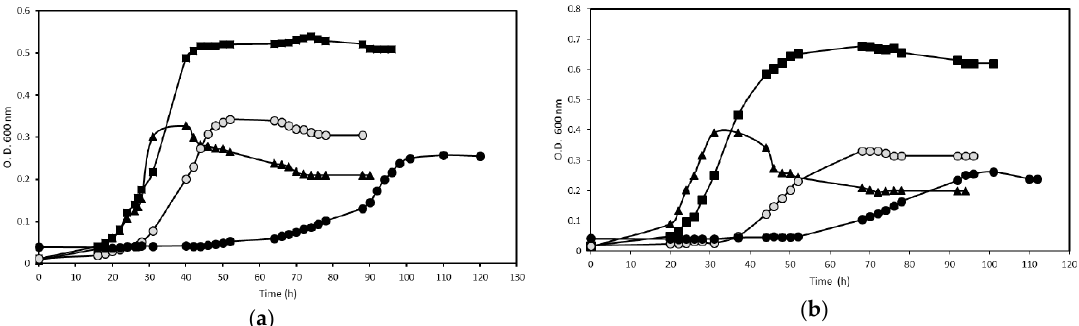
Figure 2. Growth of Pseudomonas spp. 4A ( a ) and Pseudomonas spp. ( b ) with 5 mM of HMF ( ), furoic acid ( ), furfuryl alcohol (  ) or furfural ( ● ) as the sole carbon source. Cells were inoculated in M9 media at pH 7.5 containing NH 4 Cl (5 mM) as the nitrogen source. At the indicated times, the increments of cell growth of each culture were measured. A no inoculated flask containing culture medium was used as a control (result not shown). The experiment was carried out in triplicate obtaining similar